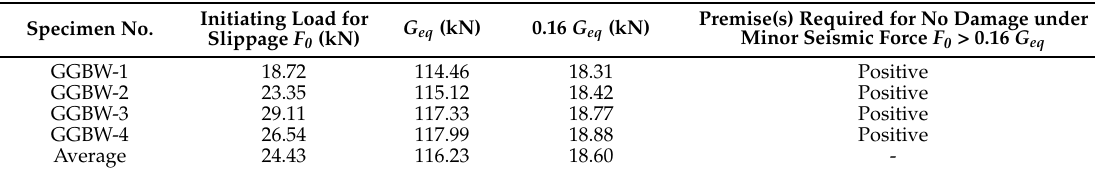
Table 5. Comparison of initiating load and corresponding seismic force (minor).